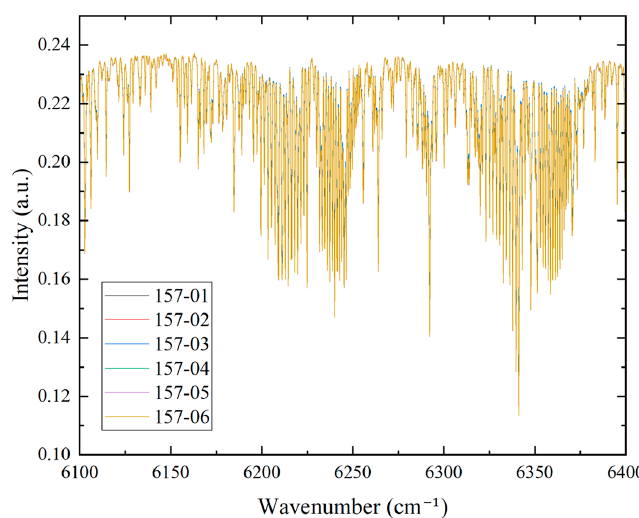
Figure 20. Results after baseline correction of spectral